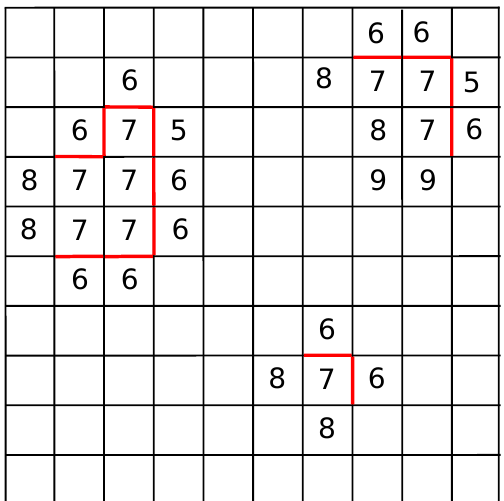
Figure 1. Schematic representation of the effective width of the 7th hypsometric bin for a region of 10km by 10km. Each square rep- resents a high resolution (1km) grid cell. The numbers define the hypsometric bin these SG grid cells belong to. The total length of all red lines (14km) represents the effective width for the 7th